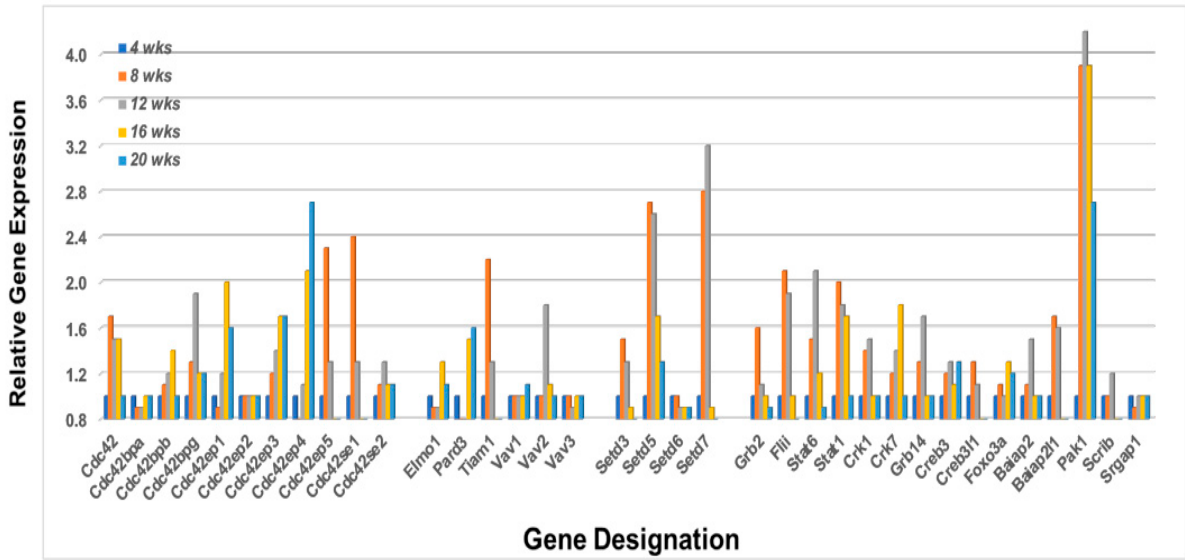
Figure 8. Temporal gene expressions for the Rho-GTP Dock gene family members. Transcriptome data showing the temporal expressions of the Dock genes upregulated in the lacrimal glands of C57BL/6.NOD- Aec1Aec2 mice. Two genes, Dock1 and Dock9 , exhibit an upregulated expression starting at 8 wks of age, while Dock2 , Dock10 , and Dock11 exhibit an upregulated expression starting at 12 wks of age.